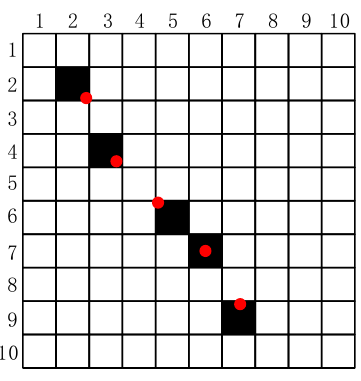
Figure 4. The trajectory points in image.